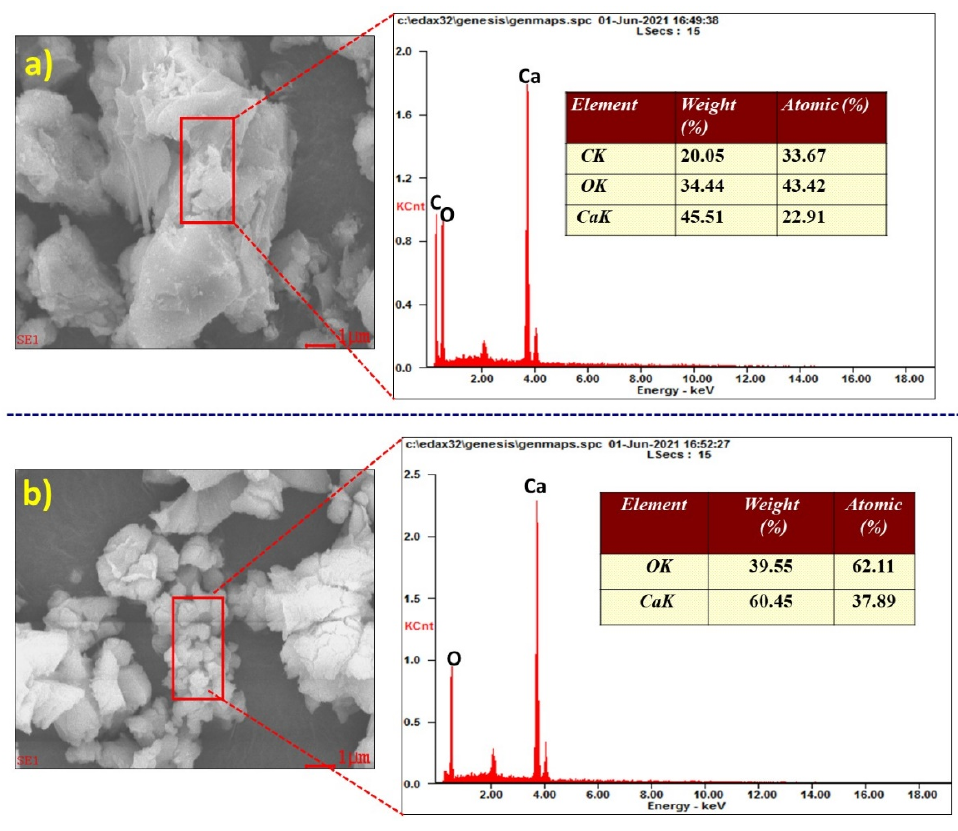
Figure 5. EDS analysis of the SSP ( a ) and SSA ( b ).